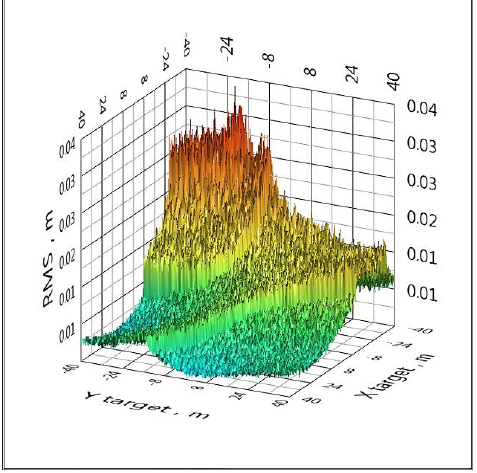
Figure 7. The distribution of the RMS coordinate estimate over the area when Gaussian noise is added to the TDoA values with a standard deviation of 10 ps (LPS).